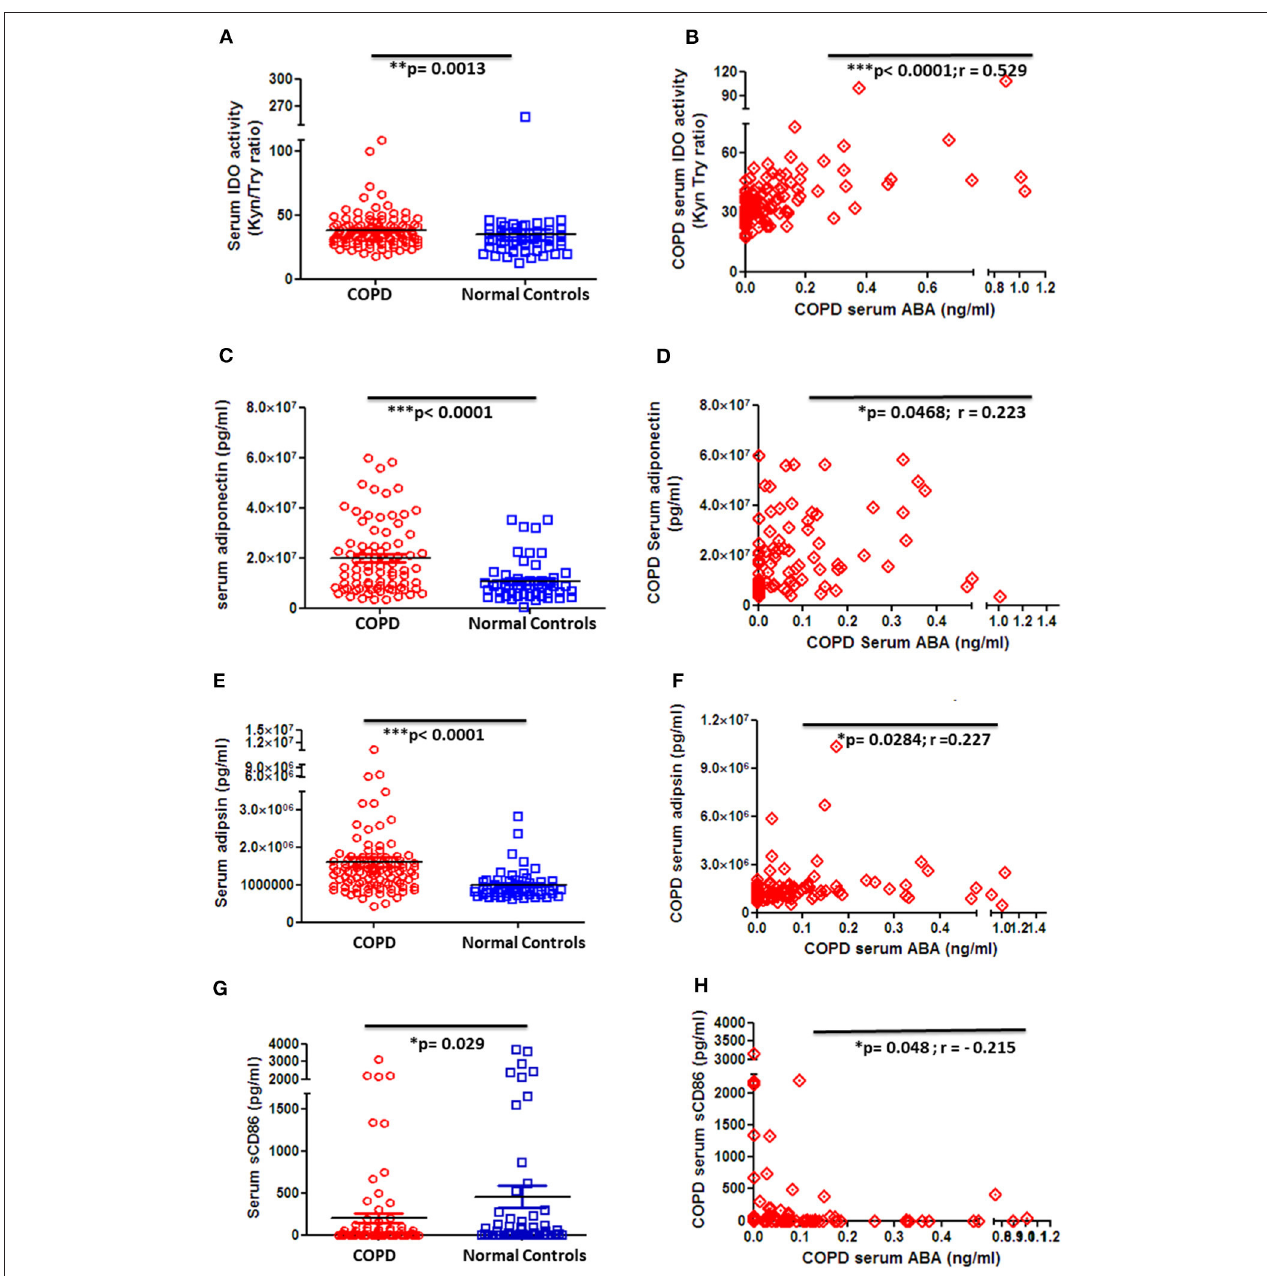
FIGURE 4 | Circulating serum levels of anti-inflammatory, insulin-sensitizing, and inflammatory markers in patients with COPD and controls. (A) Serum activity of immune-regulatory enzyme, indoleamine-2,3-dioxygenase (IDO), by measuring the kynurenine-to-tryptophan ratio in COPD patients ( n = 101) and controls ( n = 54) and (B) correlation of serum ABA levels and IDO activity among COPD patients ( n = 97). Serum levels of (C) the anti-inflammatory adipocytokine, adiponectin, in COPD patients and controls and (D) correlation of serum ABA levels and adiponectin among COPD patients. Serum levels of (E) insulin-sensitizing adipsin in COPD patients and controls and (F) correlation of serum ABA levels and adipsin among COPD patients. Serum levels of (G) the proinflammatory costimulatory molecule sCD86 in COPD patients and controls and (H) correlation of serum ABA levels and sCD86 among COPD patients. The individual dots represent data obtained